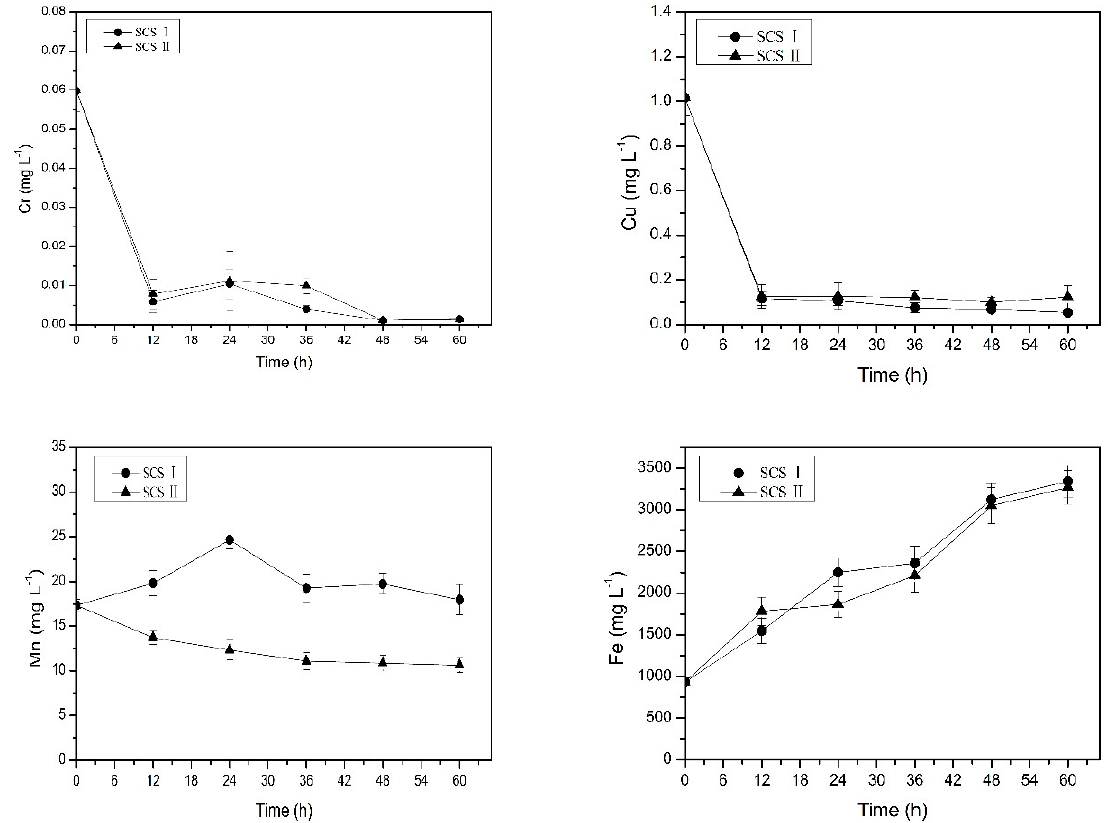
Figure 6. Change in mean concentrations of metal ions in occluded water under two di ff erent simulated corrosion scales conditions. Error bars indicate ± standard deviation.